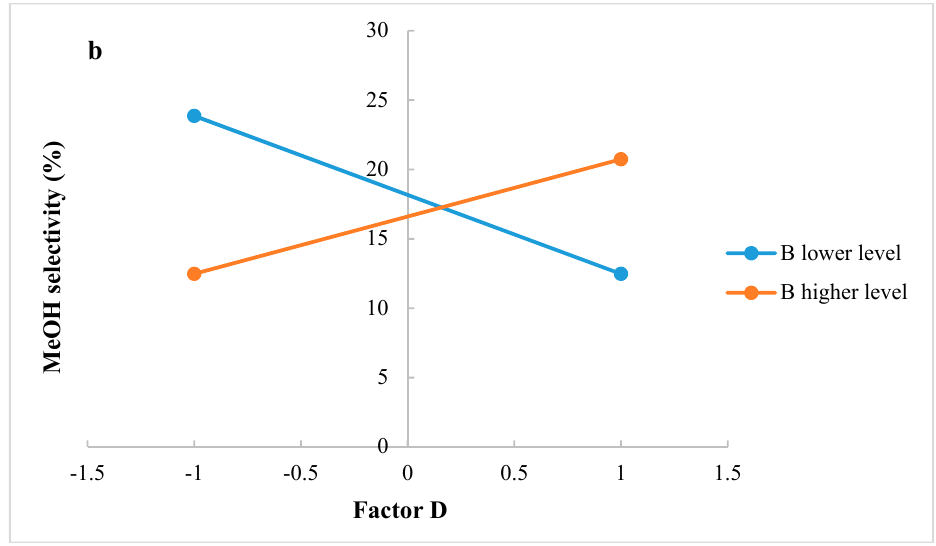
Figure 7. ( a ) Test of two levels for the analysis of interaction AC in methanol selectivity; ( b ) Test of two levels for the analysis of interaction BD in methanol selectivity (A = CO composition in mol %, B = temperature in °C, C = recycle in %, D = water removal in %).